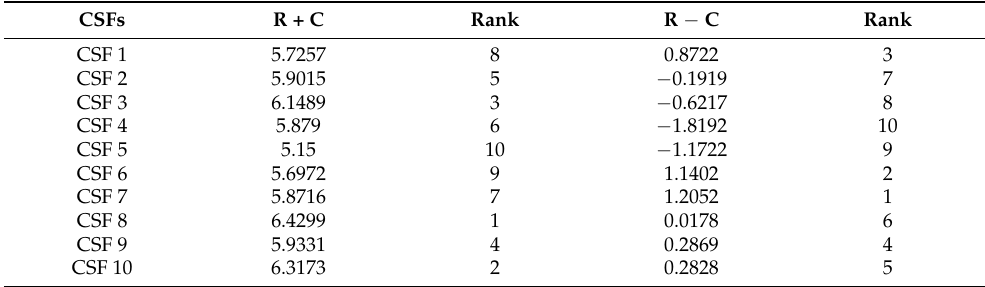
Table 8. Ranking of the CSFs towards the adoption of logistics 4.0.